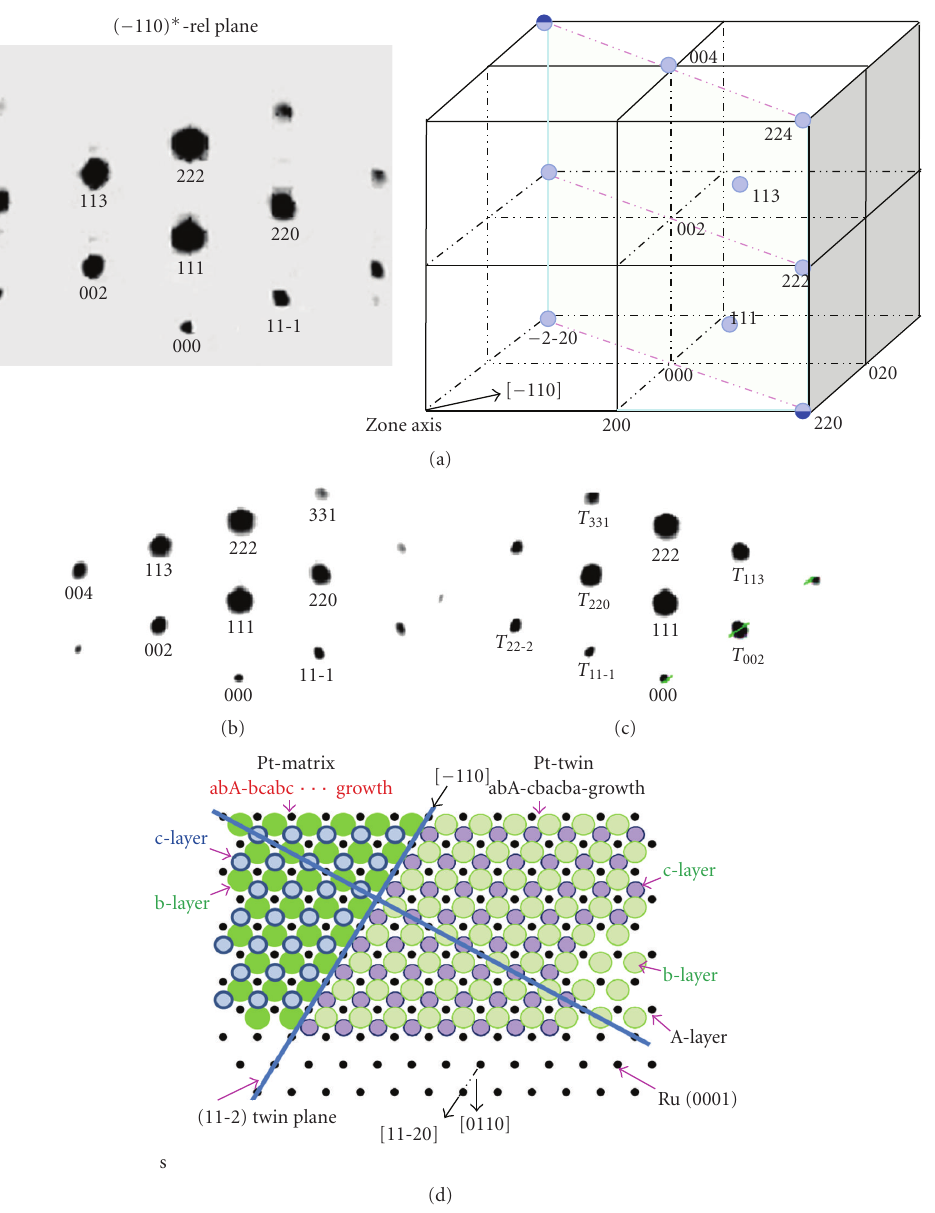
Figure 3: A reciprocal lattice intersected by a reflection sphere giving rise to a rel plane as shown by the inset (a); a ( − 110) ∗ rel-plane of the Pt matrix (b) and the corresponding ( − 110) ∗ plane of the twin crystal (c); schematic diagram of an ordered Pt matrix (crystal I) besides the twin (crystal II) grown on Ru(0001), where the [ − 110] deposit direction is parallel to the [11-20] Ru(0001) substrate